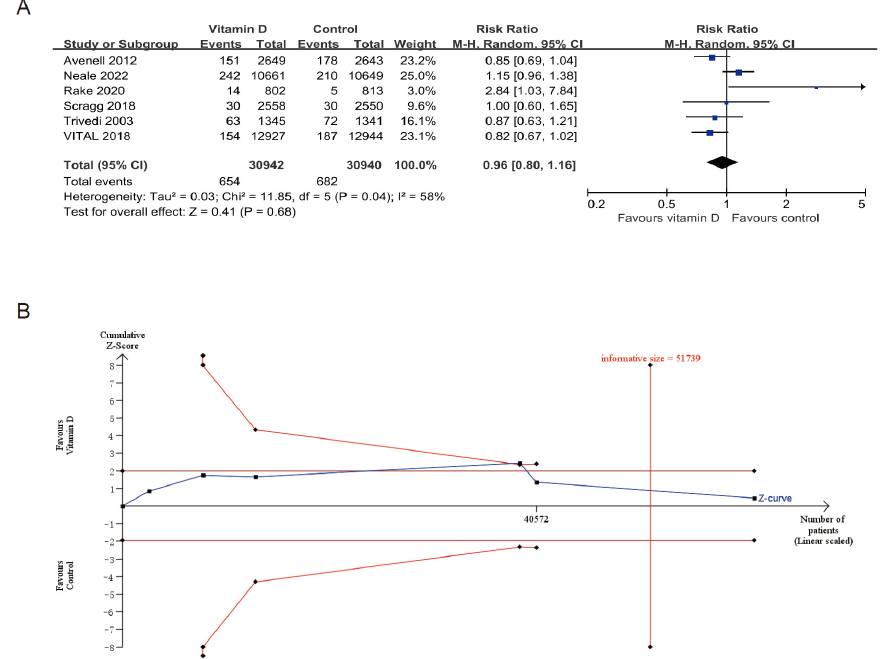
Figure 2. Exploring the relationship between vitamin D supplementation and cancer mortality. ( A ) the forest plot. ( B ) The plot of trial sequential analysis. Trial sequential monitoring boundaries were not crossed by the cumulative Z-score curve and with the addition of the latest trial, the pooled sample size exceeded the required information size.